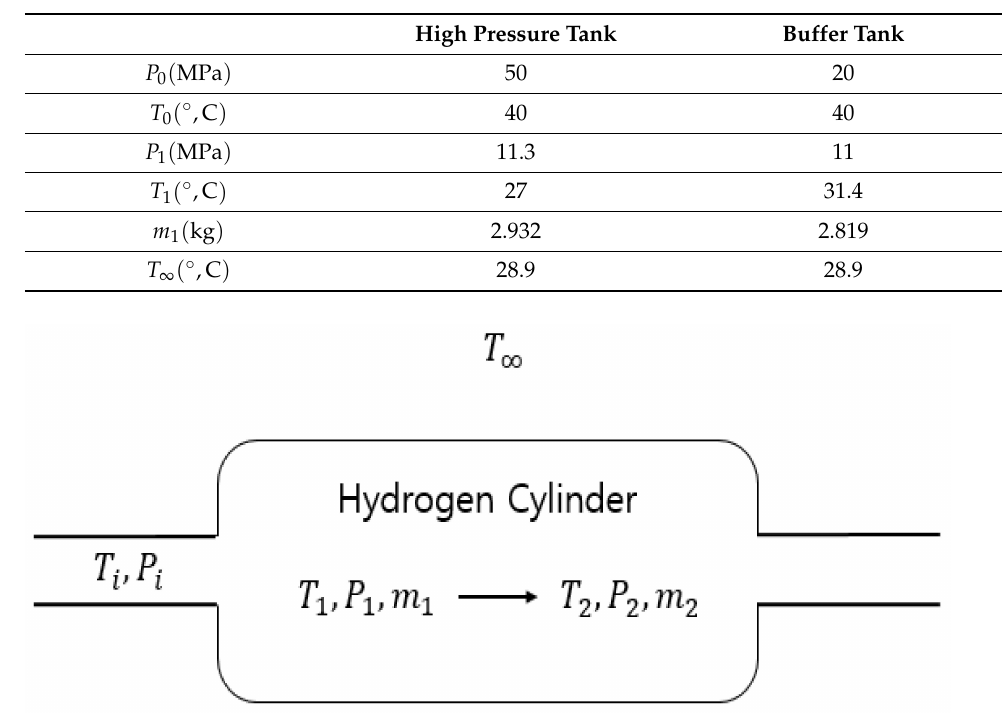
Table 2. Initial conditions of the hydrogen storage tank for the second cycle analysis.